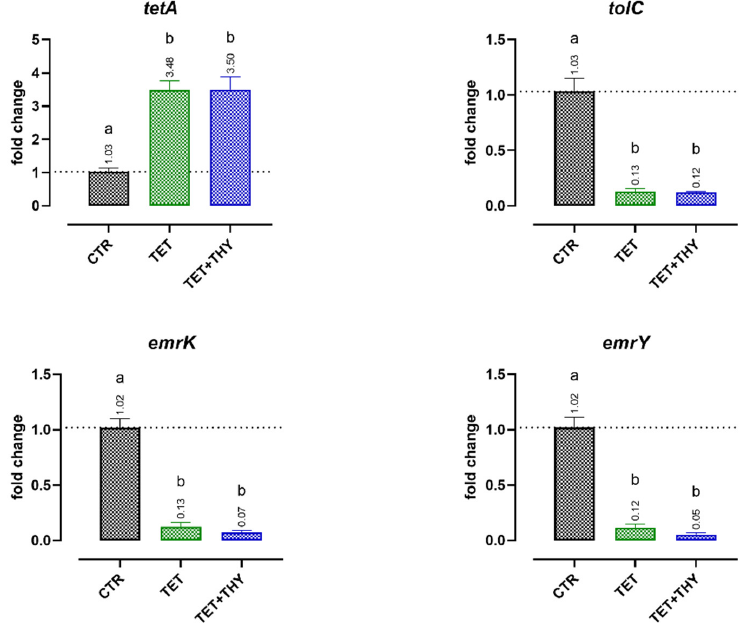
Figure 5. Effects of tetracycline (64 mg/L, TET) or a combination of tetracycline and thymol (MIC/4, 0.47 mM, TET + THY) on ETEC 95′s and ETEC 97′s expression of antibiotic resistance genes related to the production of tripartite efflux pumps ( emrK, emrY, and tolC ) and the specific tetracycline efflux